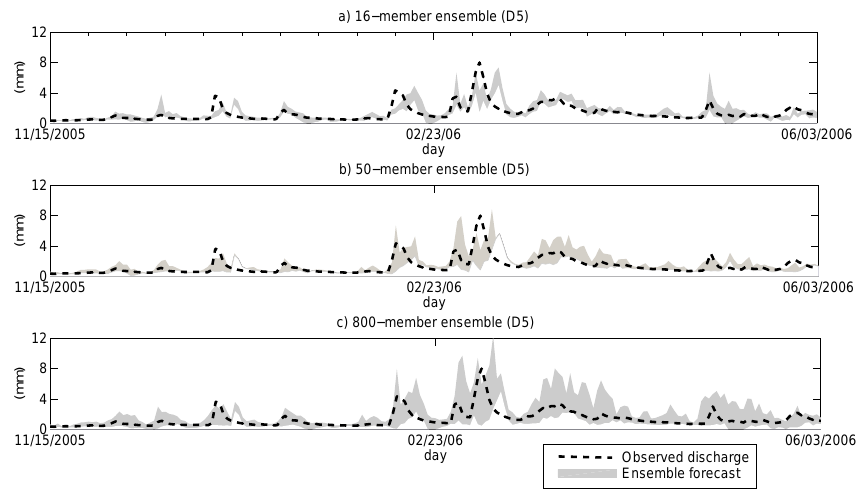
Fig. 5. Reliability Diagrams for the 29 studied catchments and lead times of (a) 1 day, (b) 3 days, (c) 5 days, (d) 7 days, and (e) 9 days, and for three types of ensemble predictions.